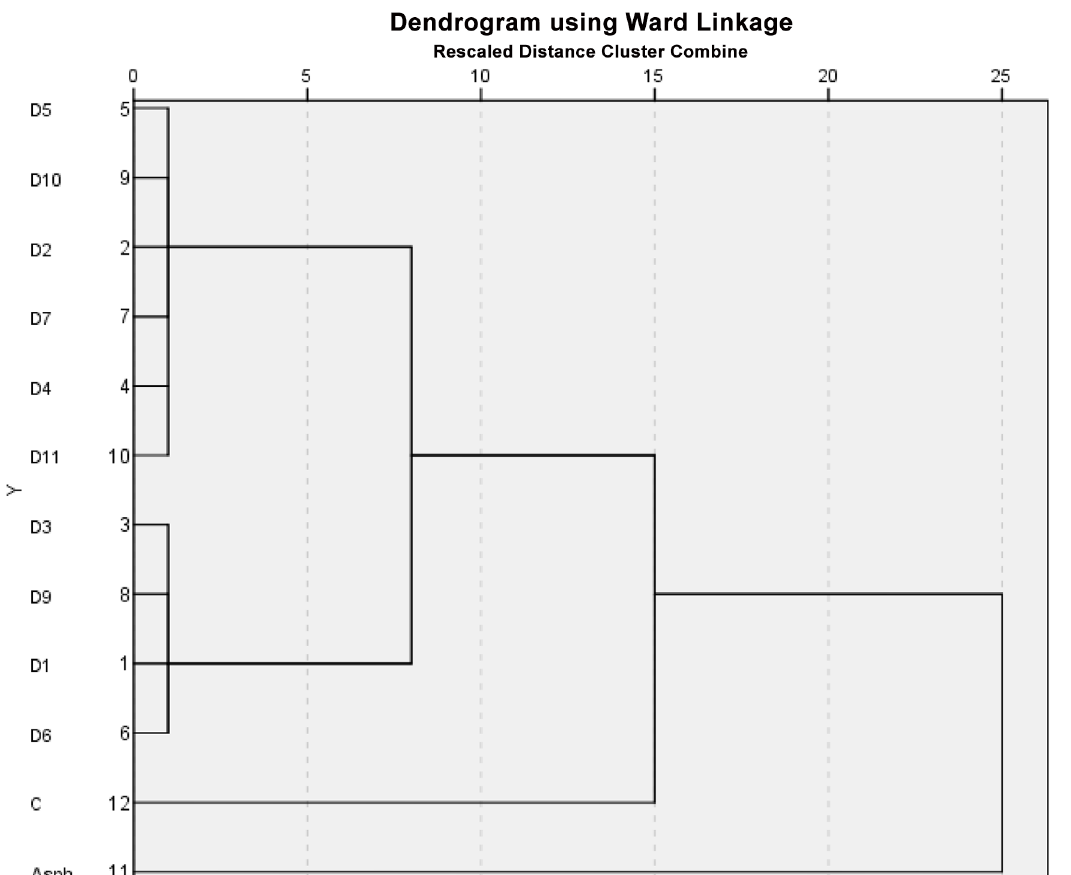
Fig 5. Plot showing the statistical output of cluster